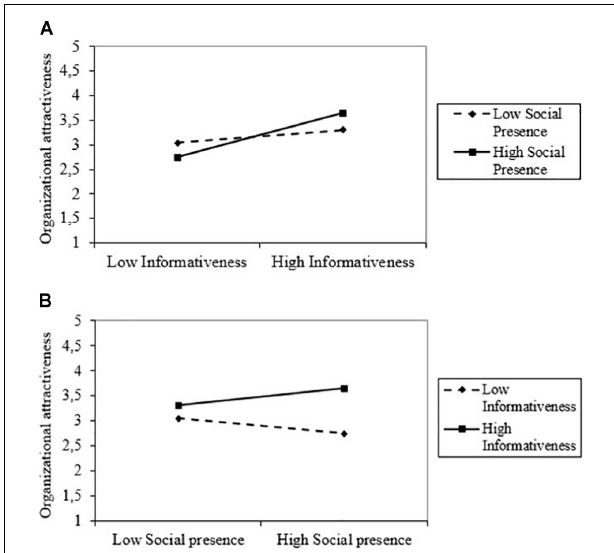
FIGURE 1 | (A) Interaction effect of informativeness and social presence on organizational attractiveness (social presence as moderator: 0 = low social presence, 1 = high social presence). The difference in organizational attractiveness between high and low informativeness is only significant when social presence is high. (B) Interaction effect of informativeness and social presence on organizational attractiveness (informativeness as moderator: 0 = low informativeness, 1 = high informativeness). The difference in organizational attractiveness between low and high social presence is never significant.